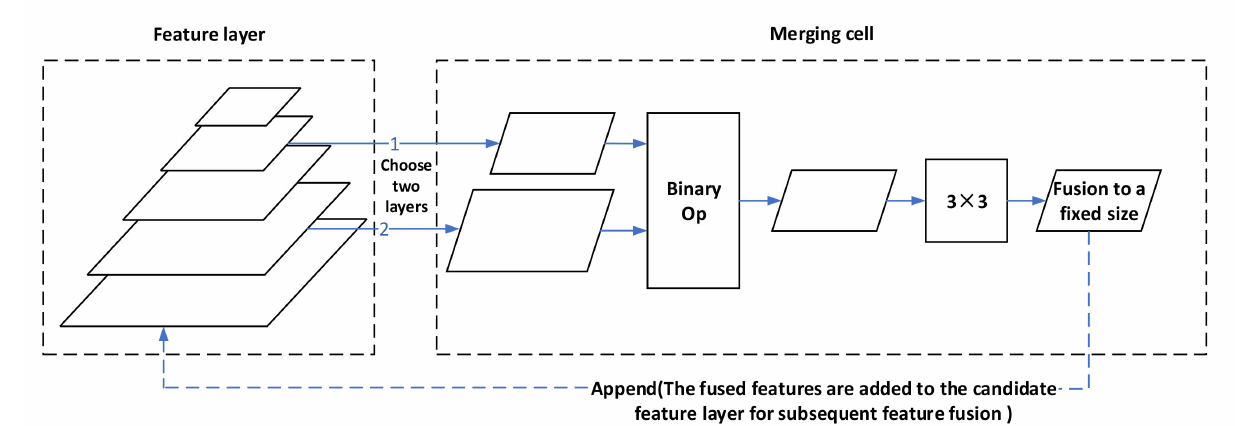
Figure 5. Structure of fusion